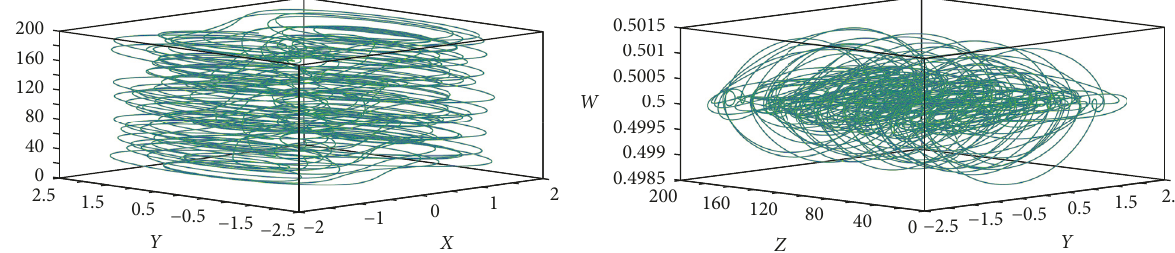
Figure 3: 3D phase portraits of the FOPF system.